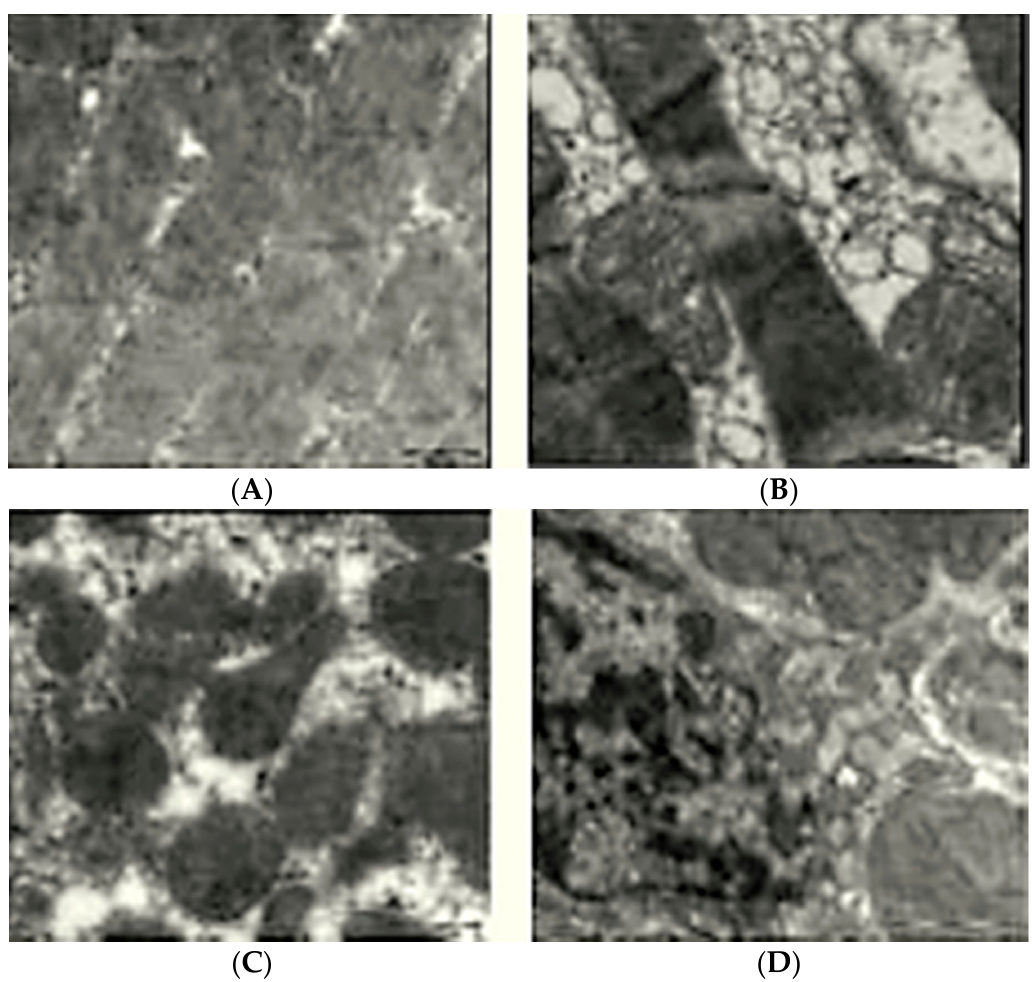
Figure 3. Effect of cardamom on ultrastructural changes in ISO-induced myocardial necrosis